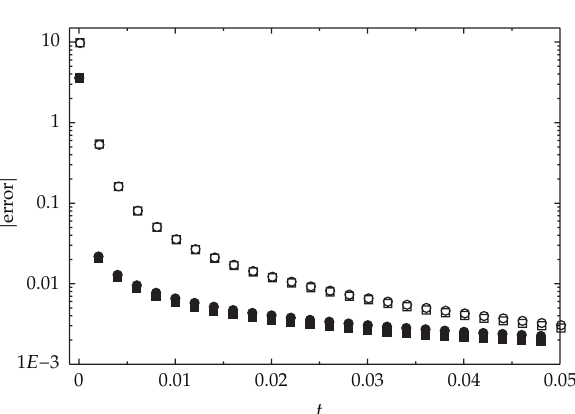
(cid:5) m (cid:6) − u (cid:5) m (cid:6) | of the numerical method for the problems considered in Figures 1 Figure 3: Absolute error | U j j and 2 at x (cid:7) 0. Squares: γ 2 (cid:7) 1; circles: γ 2 (cid:7) 1 / 2; hollow symbols: γ 1 (cid:7) 1; filled symbols: γ 1 (cid:7) 1 / 2.